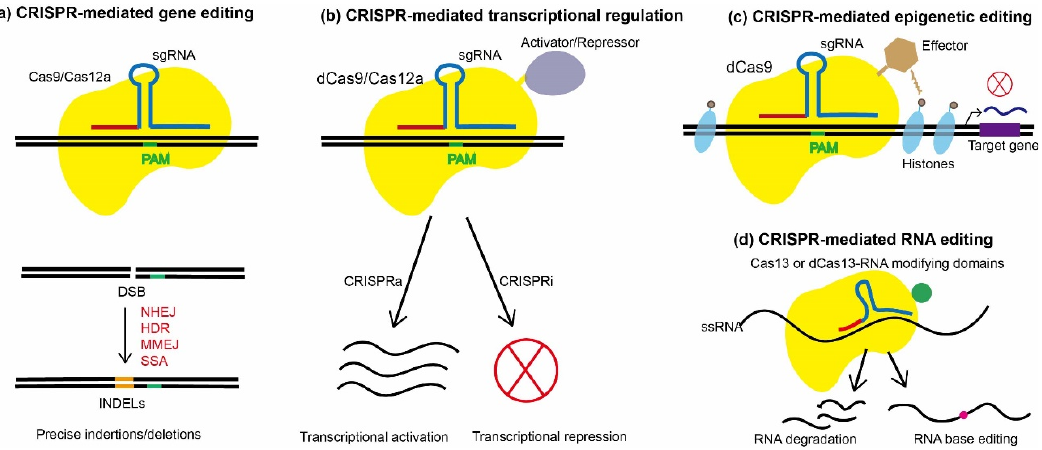
Figure 1. Diagram illustrating the mechanisms of representative CRISPR/Cas-based tools established in fungi. ( a ) CRISPR-mediated gene editing, where Cas9/Cas12a is guided to the target site with the aid of sgRNA and cleaves the target sequence, generating a double-stranded break (DSB). The DSB can be repaired via various repair pathways, including non-homologous end joining (NHEJ), homology-directed repair (HDR), microhomology-mediated end joining (MMEJ), and single-stranded DNA annealing (SSA). Various types of mutations, such as small indels, large deletions, or insertions, can be introduced at the DSB during the repairing process. ( b ) CRISPR-mediated transcriptional regulation, where deactivated Cas9/12a (dCas9/dCas12a) is fused with activation/repression domains, forming a complex that targets the promoter region of the target gene to activate or repress gene expression. CRISPRa: CRISPR-based activation; CRISPRi: inhibition. ( c ) CRISPR-mediated epigenetic editing, where dCas9 is fused with effectors, forming a complex for targeted histone modifications, impacts the expression level of the target gene. ( d ) CRISPR-mediated RNA editing uses Cas13, which has RNA-targeting activity to knockdown gene expression by triggering mRNA degradation, or uses an engineered dCas13-RNA-modifying domains-fusion protein for editing specific nucleotide residues. ssRNA: single-strand RNA; PAM: protospacer adjacent